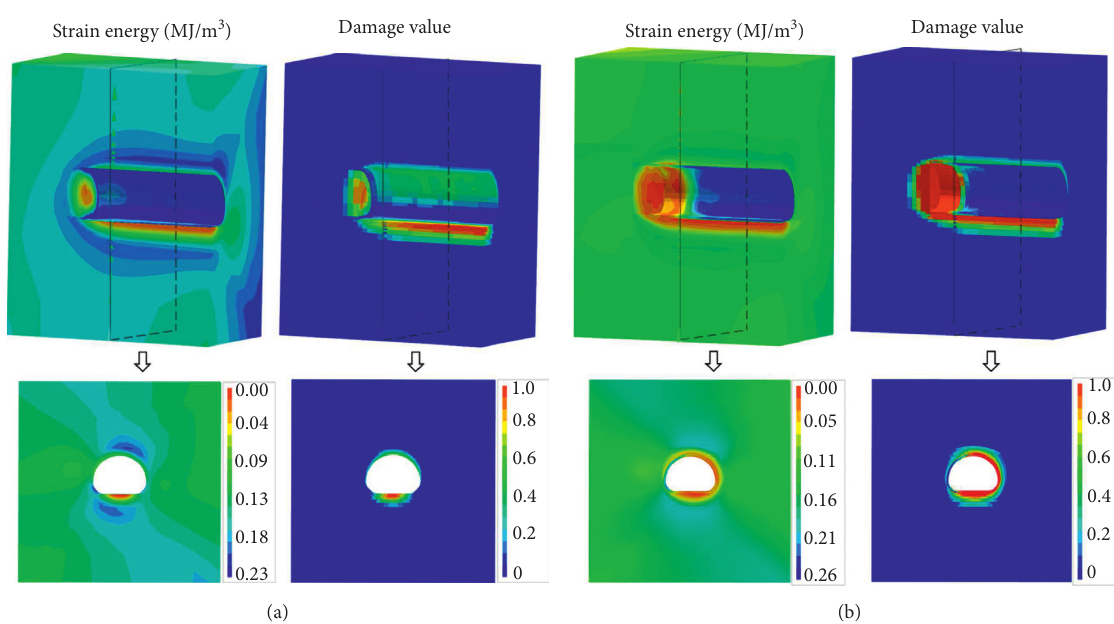
Figure 14: The simulation of front stages of rockburst under strong-stiffness support(continuous model): (a) the excavation stage; (b) the blasting vibration